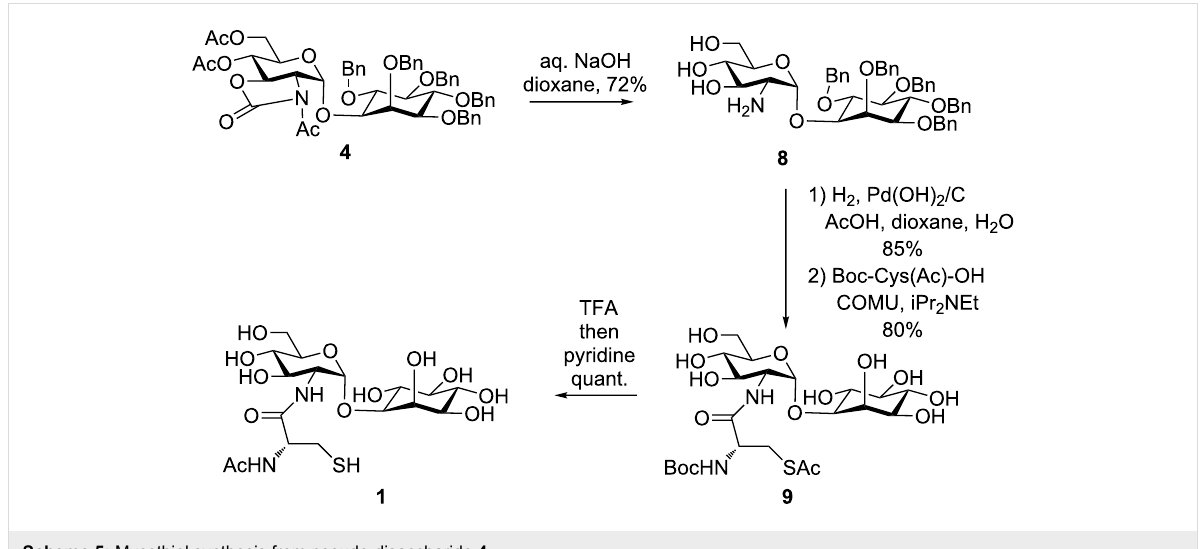
Scheme 5: Mycothiol synthesis from pseudo-disaccharide 4